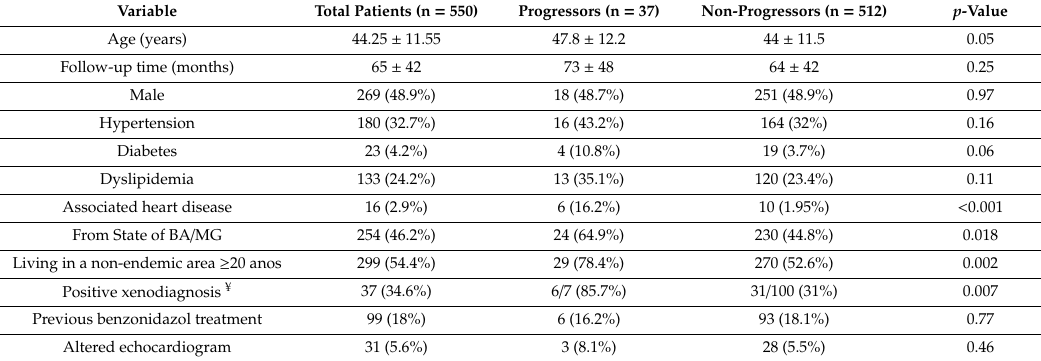
Table 1. Baseline characteristics of progressor and non-progressor patients. Age and follow-up time are expressed as mean ± standard deviation; ¥ n = 107 (7 progressors and 100 non-progressors); BA: Bahia State: MG: Minas Gerais